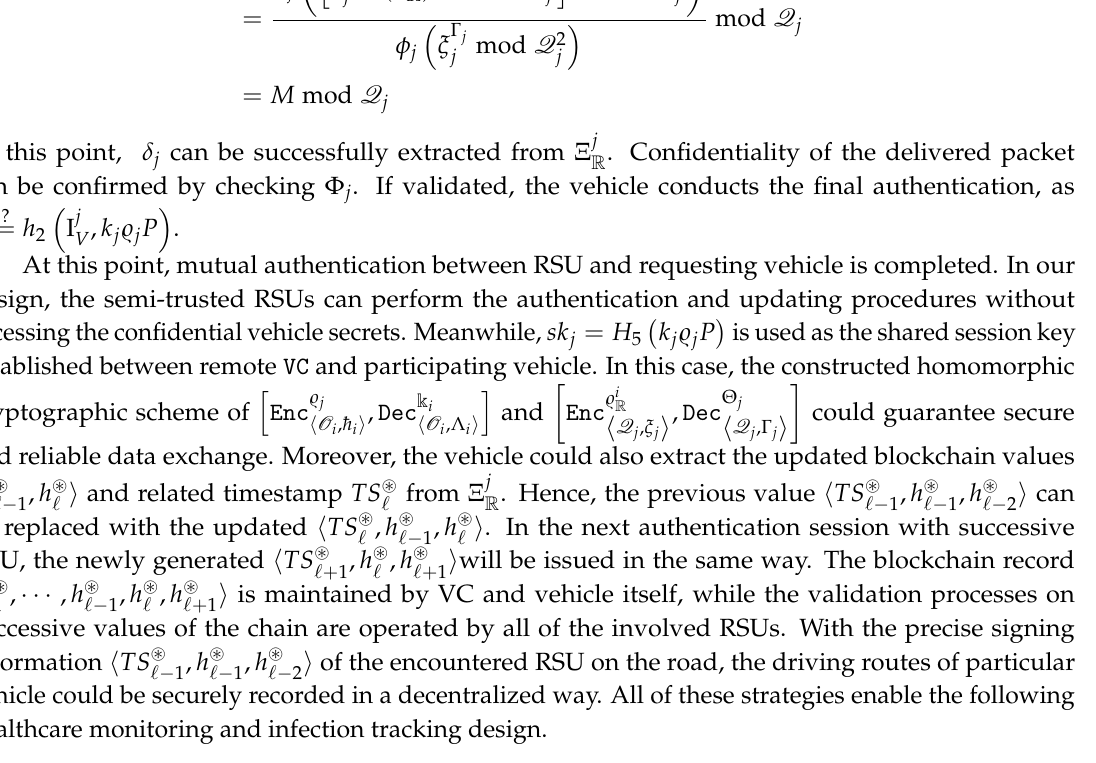
Figure 2. Regular RSU is in charge of vehicular data exchange of conventional VANETs, while the checkpoint RSUs take the responsibility of traffic surveillance and healthcare monitoring